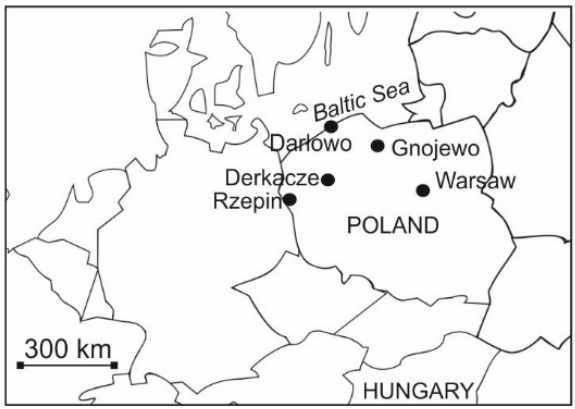
Figure 1: Location of test sites on the territory of